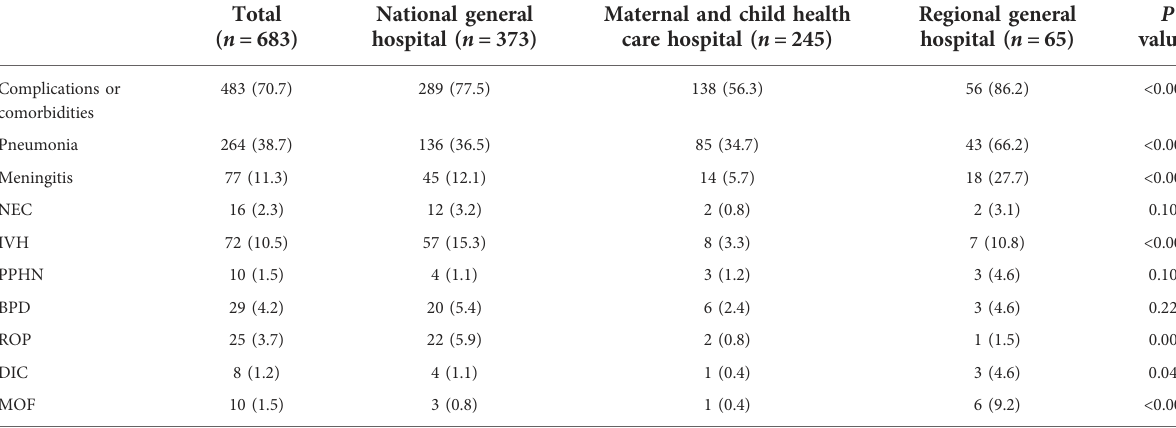
TABLE 6 Complications or comorbidities of neonates with culture-proven